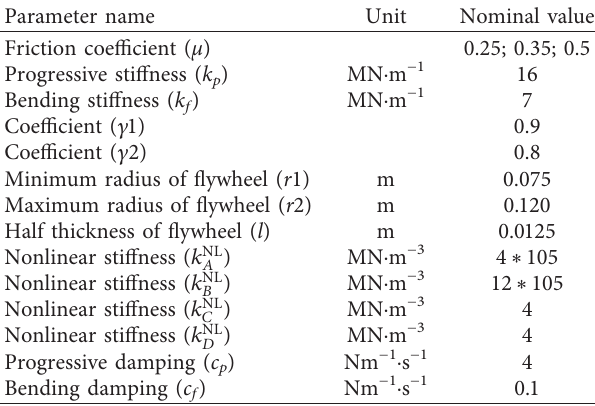
Table 1: Nominal values of the parameters of the clutch system with 6